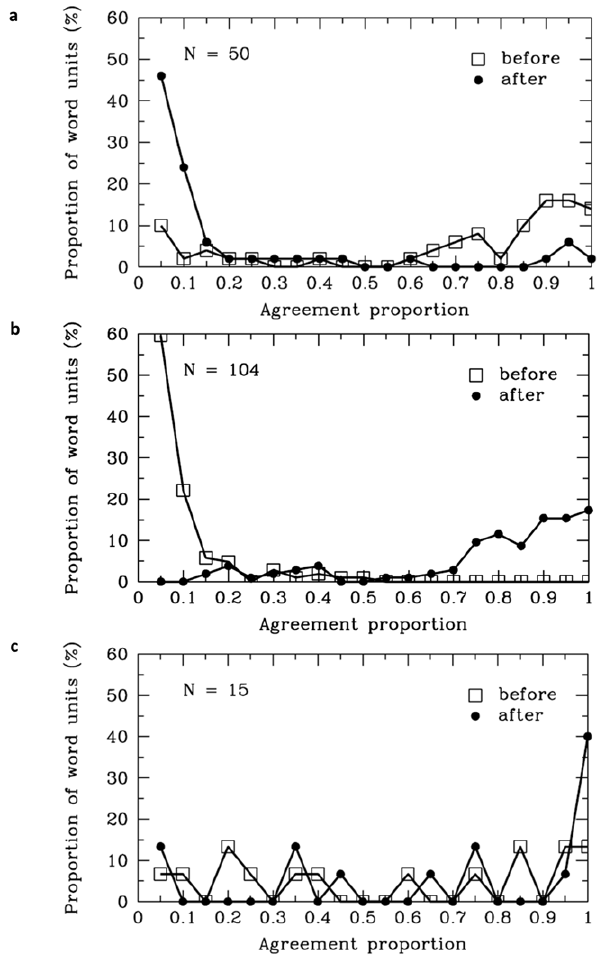
Figure 12. Numerals and Quantifiers. Frequency distribution of agreement proportions for word boundaries before (open squares) and after (filled circles) the numerals (a), the quantifiers (b), the numeral & quantifiers (c). The y-axis represents the proportion of SWU. The number of SWU was also present in each panel of the figure.